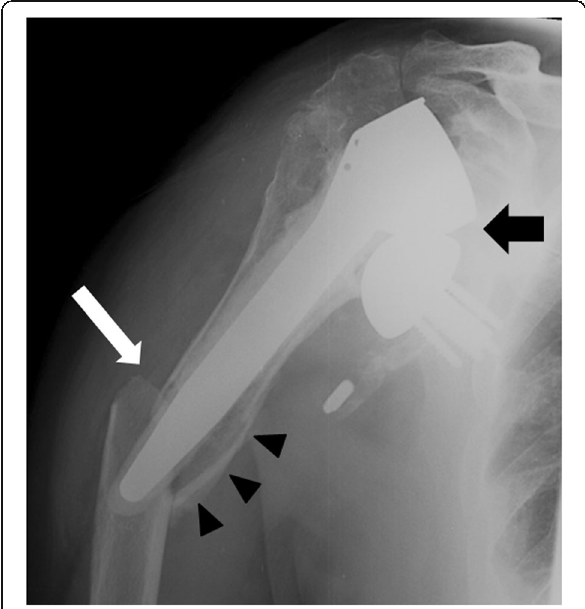
Fig. 7 Anteroposterior radiograph of a 73-year-old man shows a periprosthetic fracture (white arrow) and a complex glenohumeral dislocation (black arrow). Note that there was previously a stress shielding manifested by cortical thinning and radiolucency area around the distal humeral stem